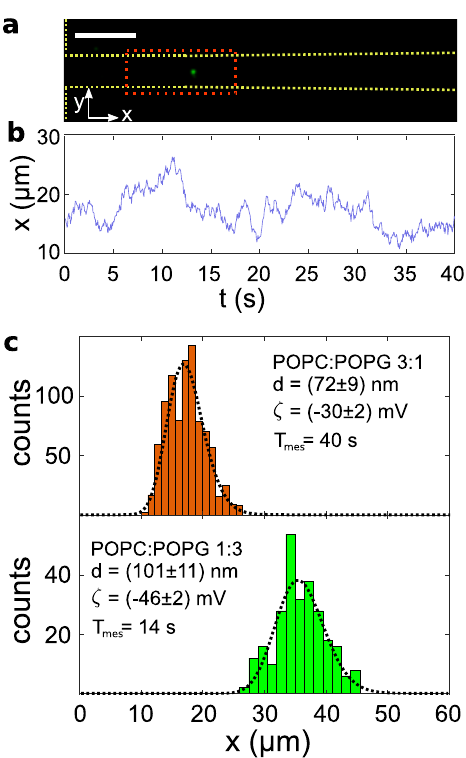
Fig. 3 (a) Fluorescence microscopy image of a single liposome trapped by a salinity gradient in a nanochannel. (b) The x- coordinates of a single, trapped liposome in a nanochannel. (c) Histogram of the x-coordinates shown in panel b and corresponding fit (top), and a similar histogram and corresponding fit for a liposome with a different size and zeta potential (bottom)